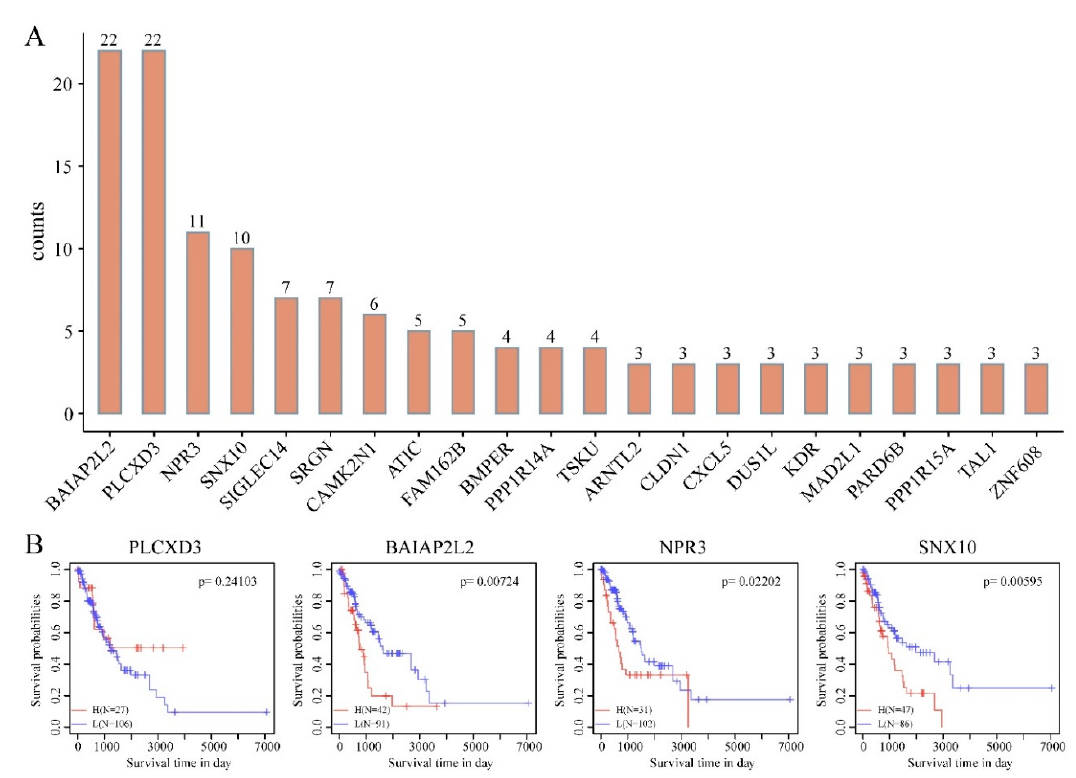
Figure 7. Identification of 4-DMEG risk signature for survival by Least Absolute Shrinkage and Selection Operator (LASSO) regression analysis. ( A ) Number of occurrences of each probe in 100 rounds of random sampling. ( B ) Kaplan-Meier (KM) analysis of 4 candidate DMEGs with frequencies ≥ 10 rounds. Table 2. 4-DMEGs based signature.